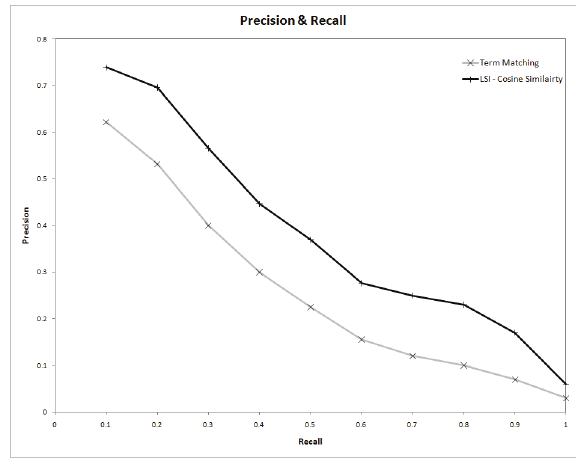
Fig. 10. Precision and recall results comparing LSI to TF-IDF in- dexing